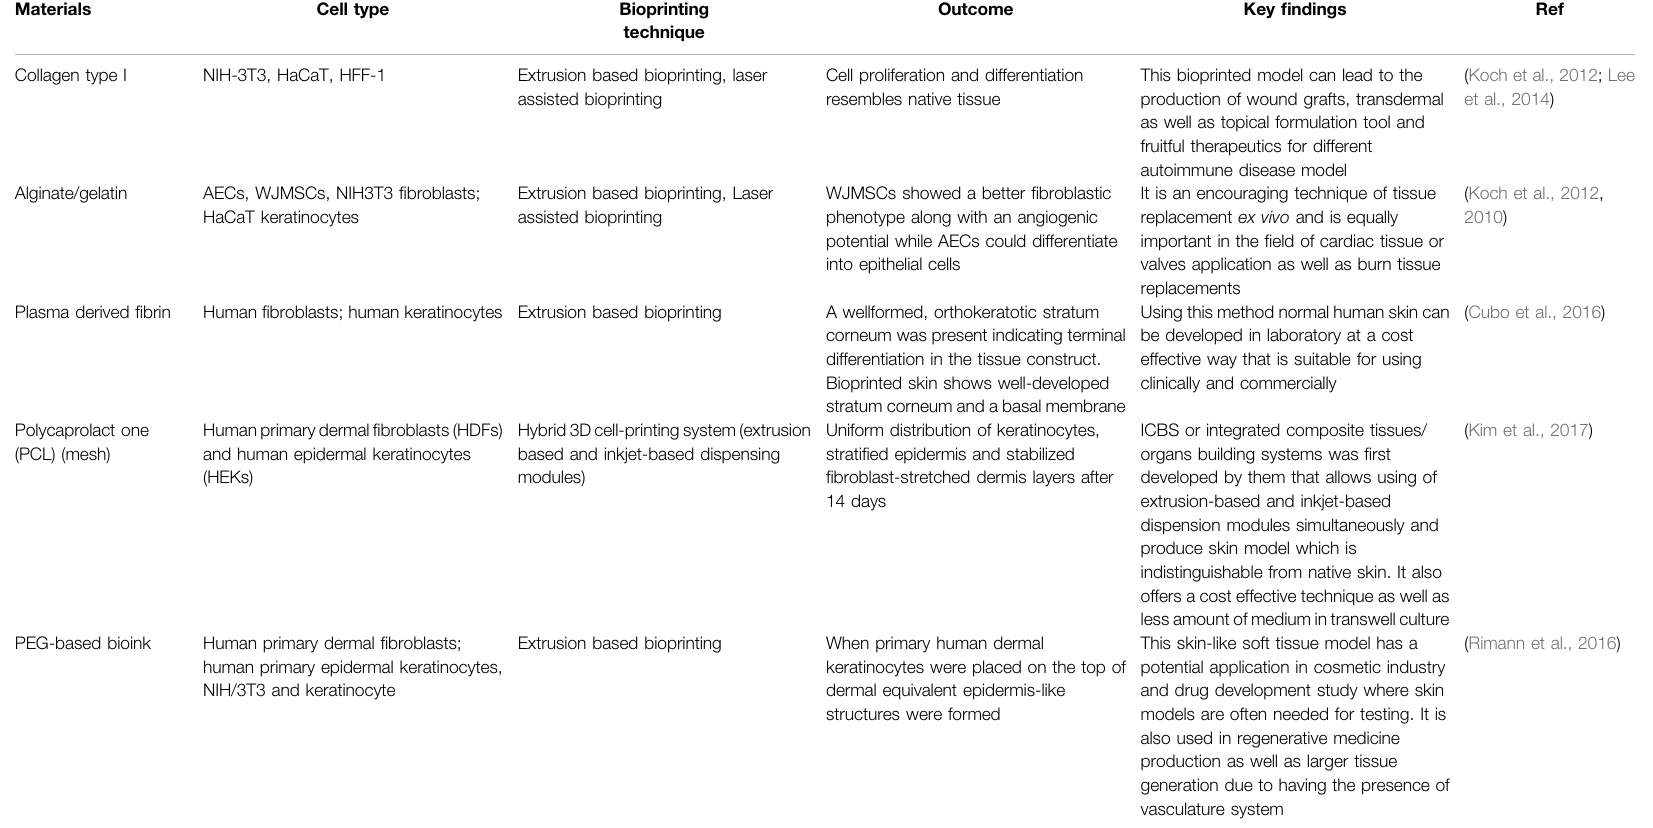
TABLE 2 | Comparative summary of different 3D bioprinting techniques used in skin tissue